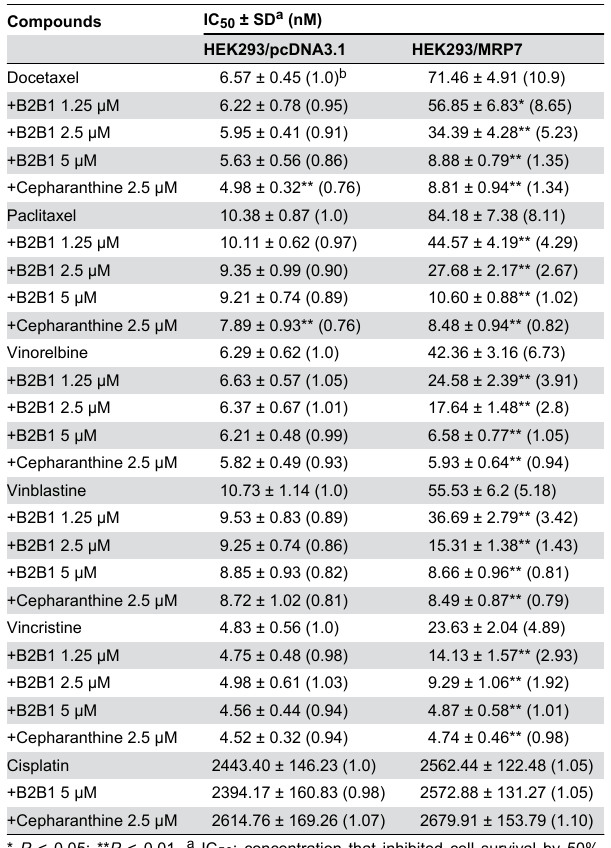
Table 1. The effect of BBA on the sensitivity of HEK293/ pcDNA3.1 and HEK293/MRP7 cells to docetaxel, paclitaxel, vinorelbine, vinblastine, vincristine and